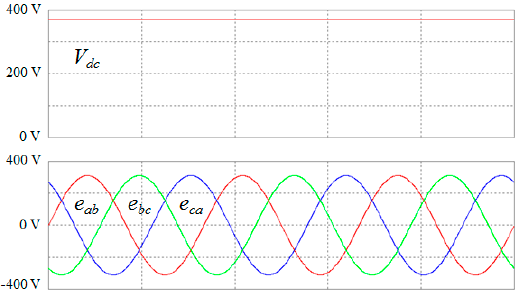
Figure 10. Simulation results of the proposed inverter: e ab , e bc , e ca , and V dc .